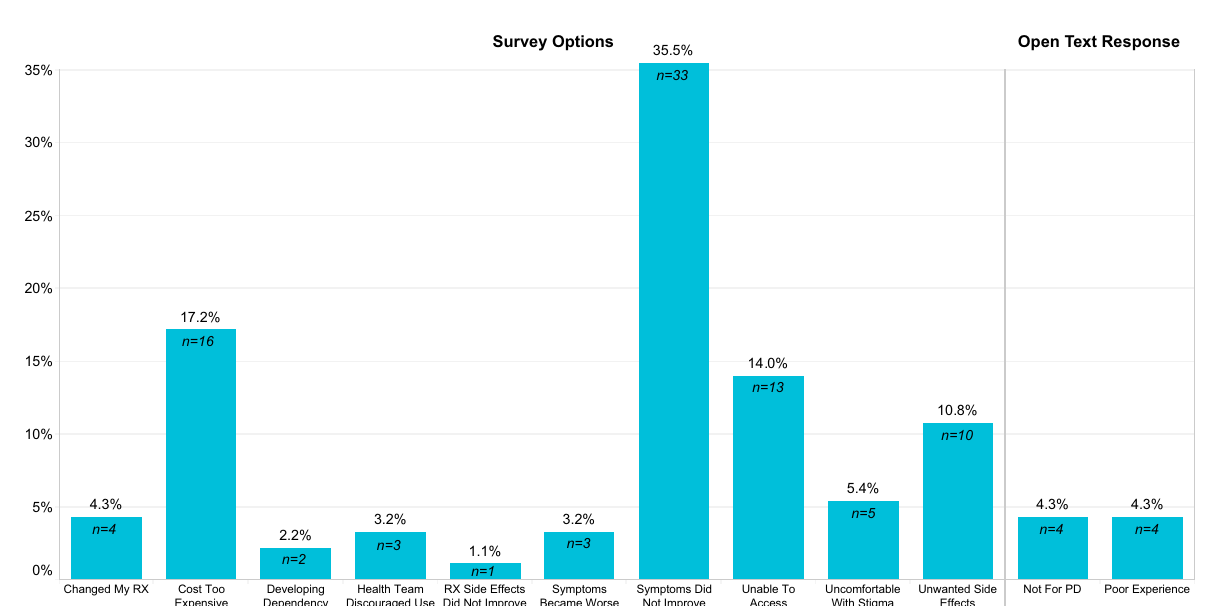
Fig. 5 Reported reason for cannabis cessation. Users and former users ( n = 93) responded to the survey question “ For what reason did you stop using marijuana or cannabis? ” Responses were either pre-identi fi ed as one of the survey options or individuals selected “ other ” and their open text response was analyzed thematically. Lack of symptom improvement was a key reason for halting cannabis